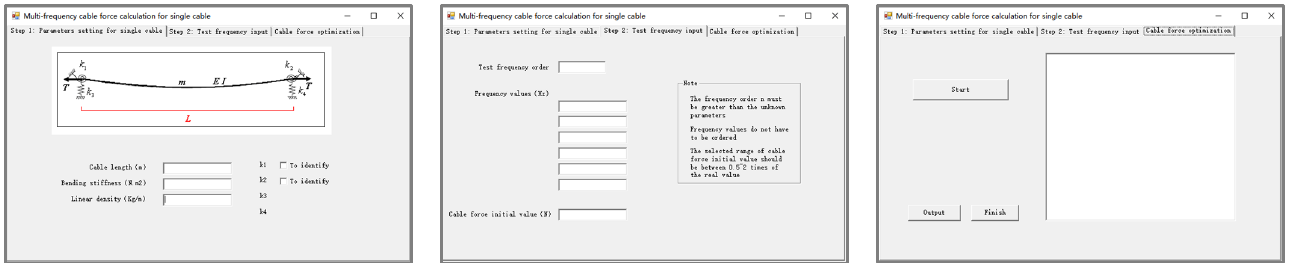
Figure 21. Single-cable force calculation with an arbitrary boundary.